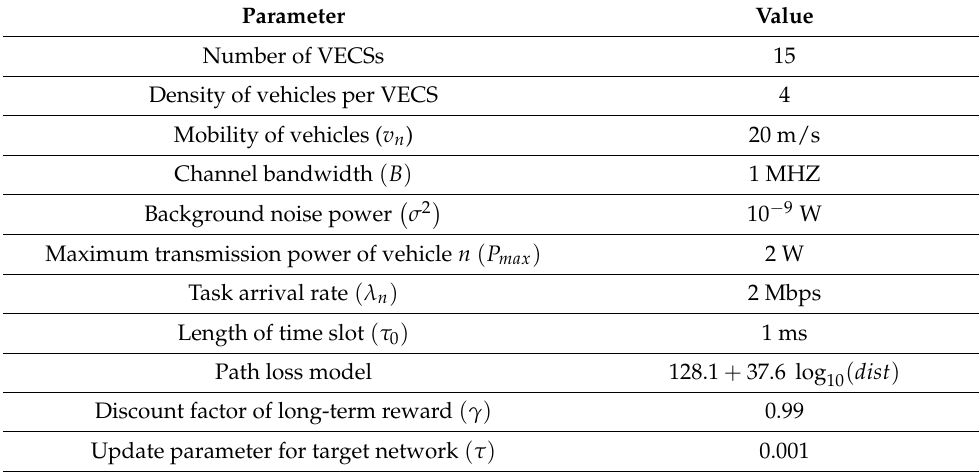
Table 1. Simulation